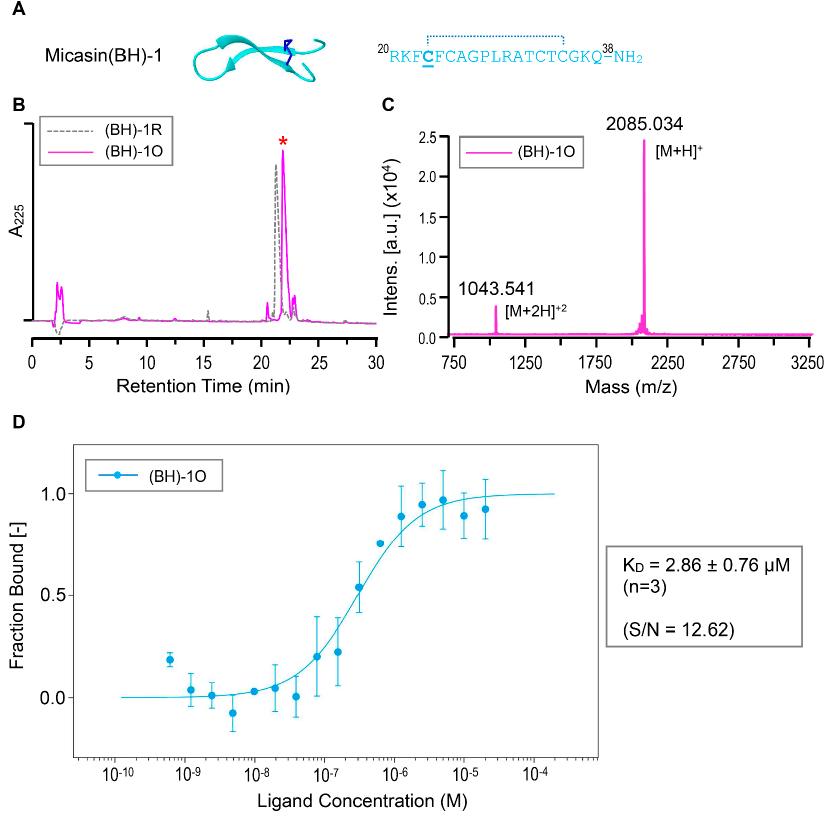
Figure 4. Interactions between (BH) − 1 and RBD. ( A ) Sequence and the computational model. The cysteine mutated from the Gly located on β 1 is underlined once and the proposed disulfide bridge is denoted by a dotted line. ( B ) RP − HPLC profile of the reduced [(BH) − 1R] and oxidized [(BH) − 1O] products. The latter marked by a red asterisk was produced via air oxidization. ( C ) MALDI − TOF determining the molecular mass of (BH) − 1O showing two peaks corresponding to its singly and doubly protonated forms. ( D ) Quantification of binding affinity of (BH) − 1O to NT − 495 − labelled RBD by MST. The dose − response curve for interactions was fitted with the K D model. Error bars are SDs from three independent measurements. The experiments were performed at 25 °C at high MST and 20% LED power. S/N, signal − to − noise ratio. 3.4. Structure − Based Design Improving the RBD Binding Affinity of Micasin